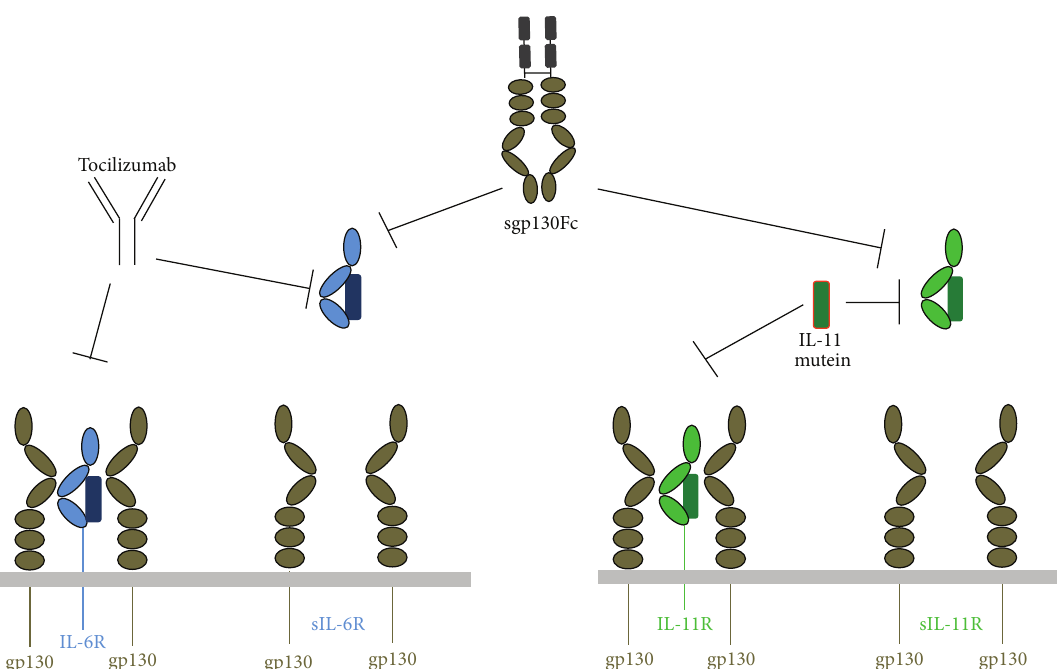
Figure 3: Strategies to inhibit IL-6 and IL-11 signaling. Both sIL-6R/IL-6 and sIL-11R/IL-11 complexes can be specifically blocked by sgp130Fc, which does not bind IL-6 or IL-11 in the absence of their soluble receptors. The monoclonal antibody tocilizumab binds to IL-6R and thus blocks IL-6 classic signaling and trans-signaling. An IL-11 mutein, which binds to the IL-11R but does not activate intracellular signaling via gp130, blocks both IL-11 classic signaling and